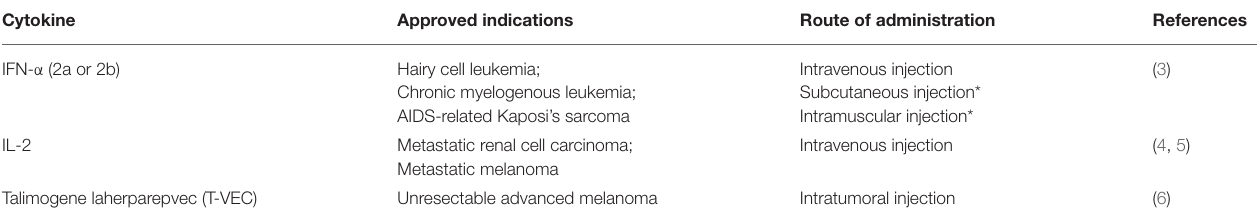
TABLE 1 | Approved cytokine monotherapies and cytokine-enhanced therapies for cancer.